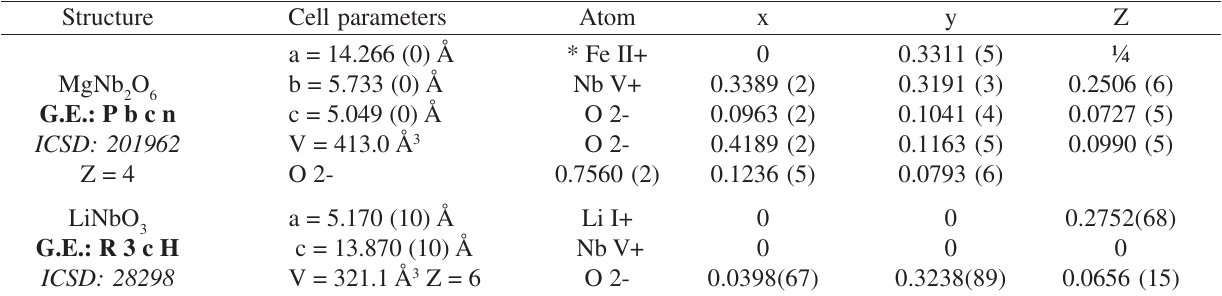
Table 1. Initial structures for the identified phases in the studied precursor